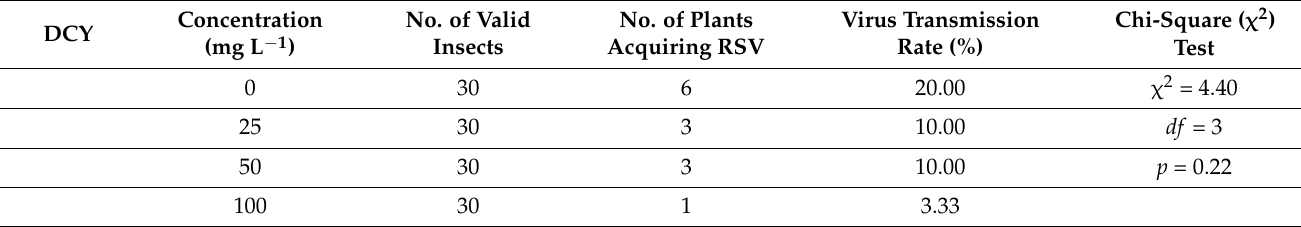
Table 1. RSV inoculation rate of SBPH fed on DCY-treated